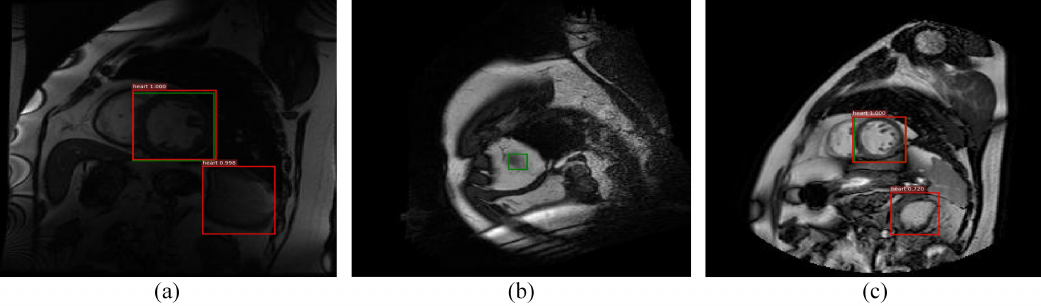
Figure 13. Examples of false or missed detection in the proposed method, where ( a , c ) are examples of false detection, and ( b ) is an example of missed detection. The green boxes and red ones denote the label and detection results,